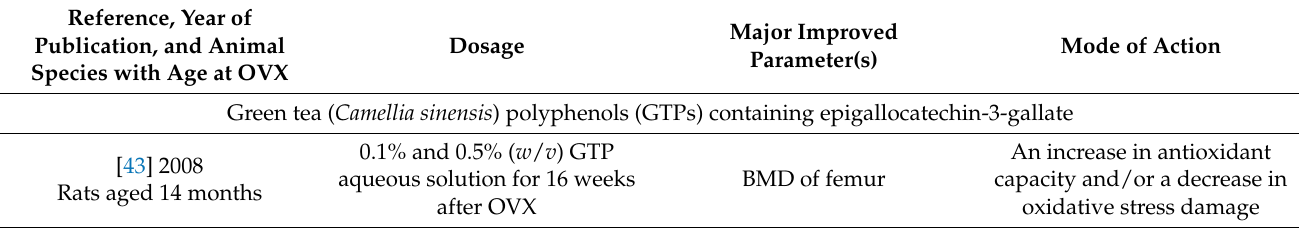
Table 3. Beneficial effects of oral polyphenol-rich substances or extracts on osteoporosis in ovariec- tomized